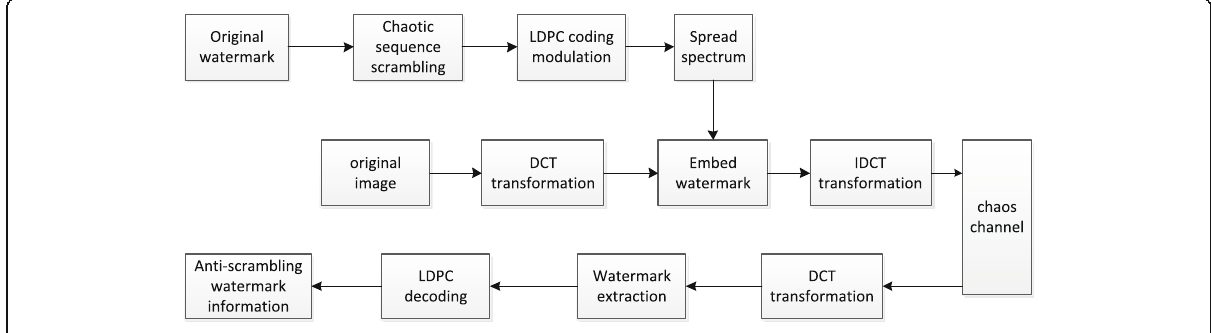
Fig. 6 Improved algorithm flow